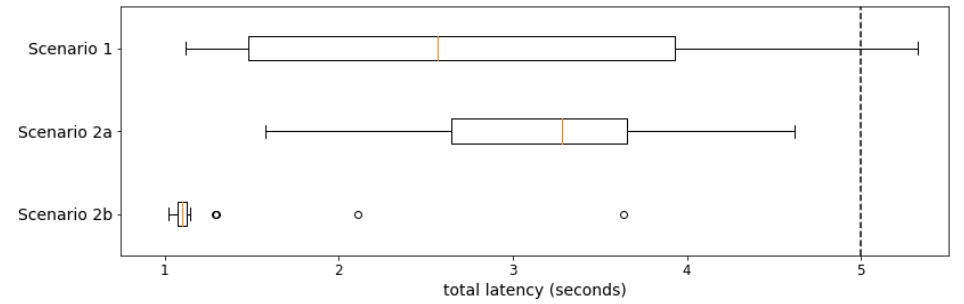
Figure 7. Boxplot showing the distribution, over all scenario runs, of the total system latency of three types of observations: the observation in scenario 1 causing a WarnNurseAction handled locally, the observation in scenario 2a leading to a CallNurseAction handled by the back-end, and another observation in scenario 2b that causes the creation of another WarnNurseAction . The vertical dashed line indicates the 5 s threshold, which is the targeted maximum system